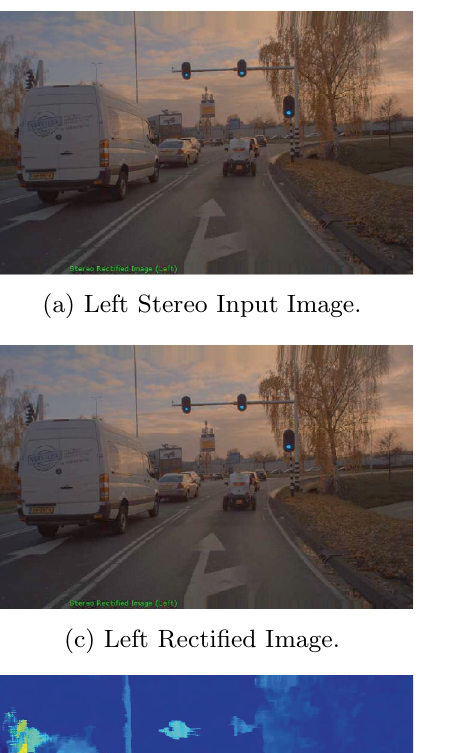
(e) Stereo Disparity Map. (f) Object Detection.